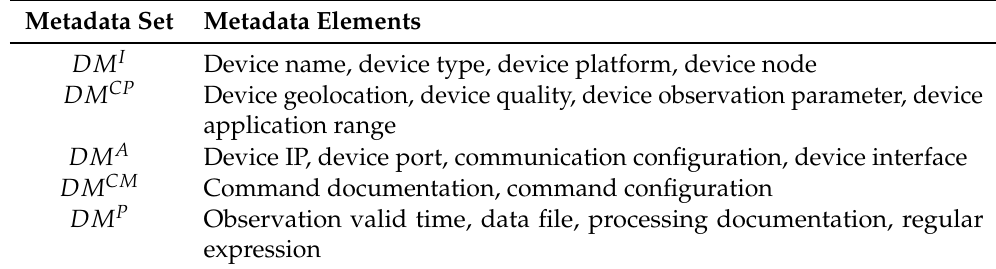
Table 2. The detailed characteristics contained in DC .